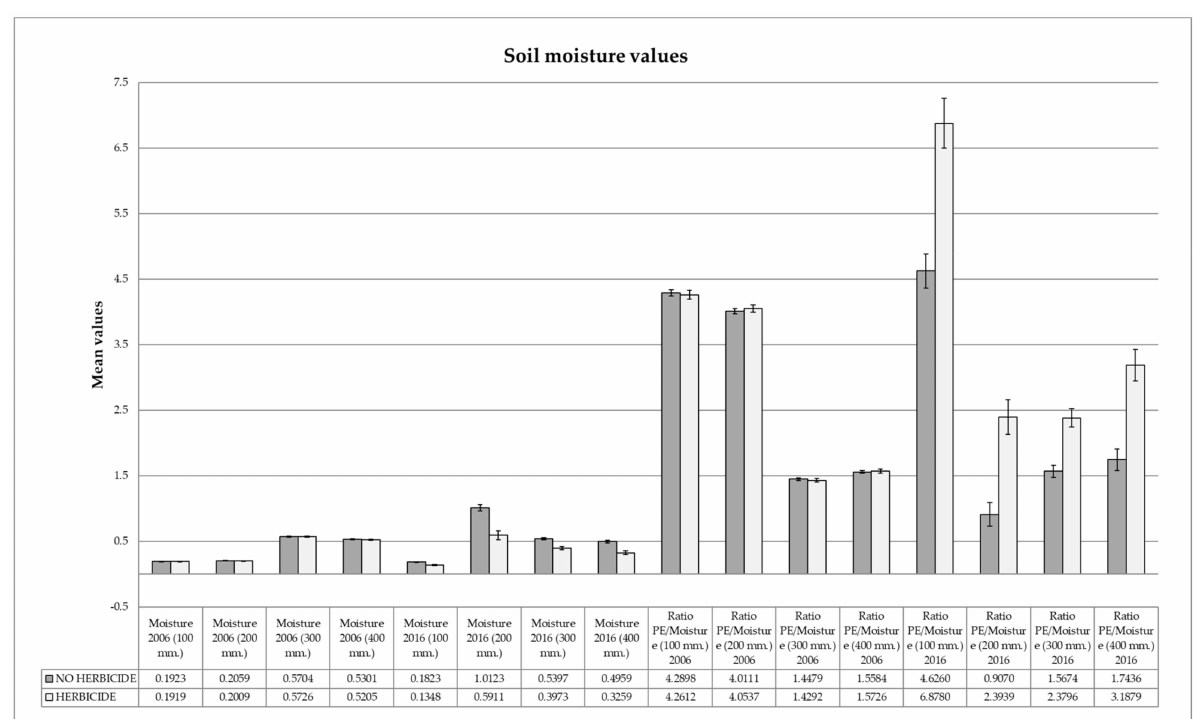
Figure 10. Differences in soil moisture values and PE /soil moisture ratio at different depths in the two time periods (2006–2016) for the two types of grass cover management (herbicide vs. no